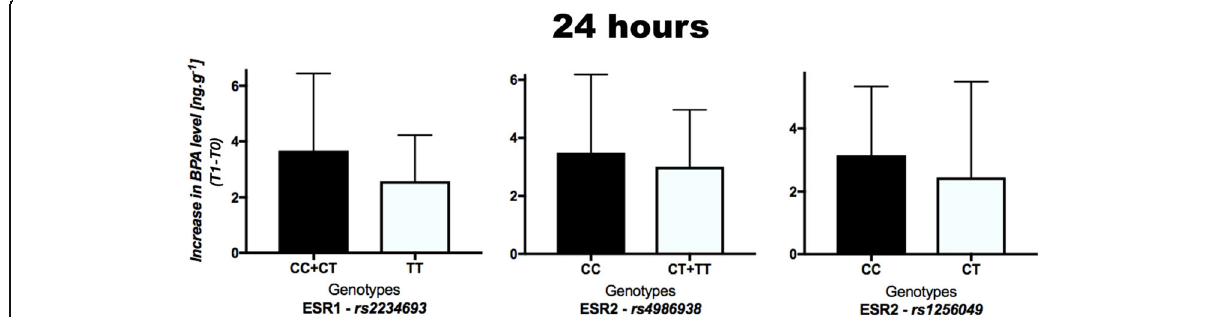
Fig. 1 Means (SD) of the increase of BPA levels in urine 24 h after bracket bonding (T1 – T0) according to genotype